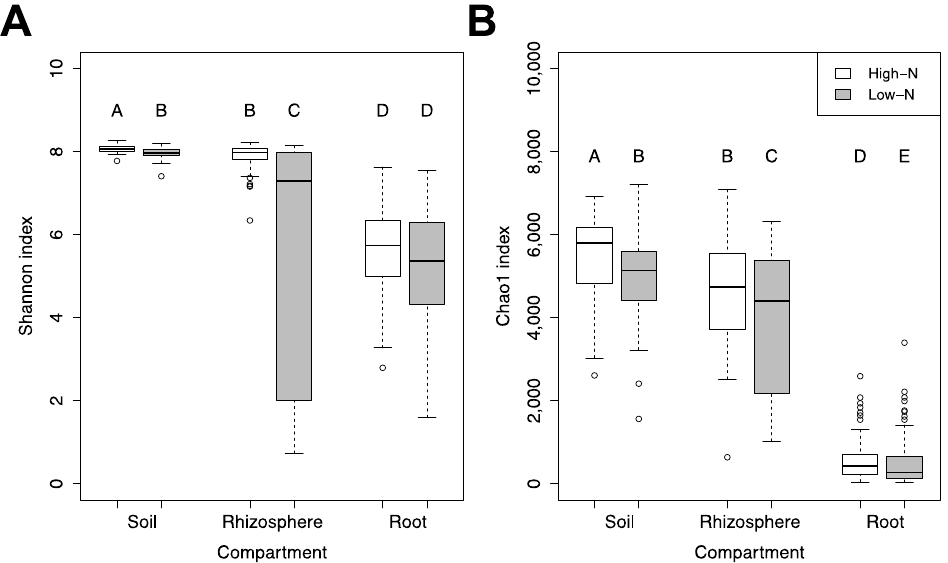
Figure 2. Differences in α -diversity between the three compartments and two N-levels. Box plots of α -diversity at two N-levels in soil, rhizosphere, and root endosphere compartments in both years sampled. ( A ) Differences in species diversity calculated by the Shannon index; and ( B ) differences in species richness calculated by the Chao1 index. Different letters indicate significant differences according to Wilcoxon’s pairwise test.